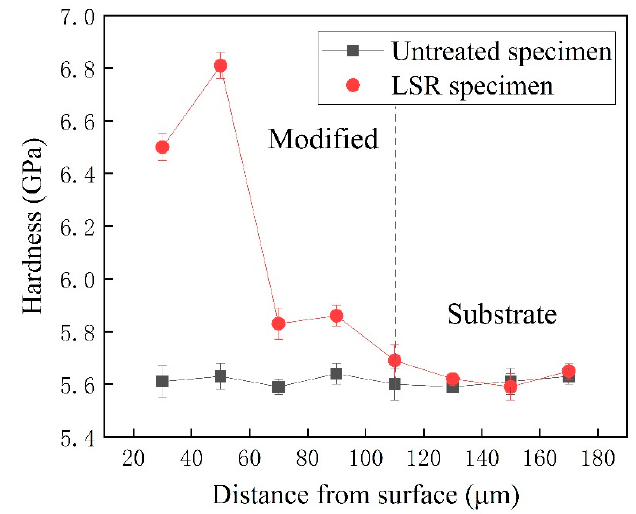
Figure 7. Hardness gradient of bainitic steel after LSR.